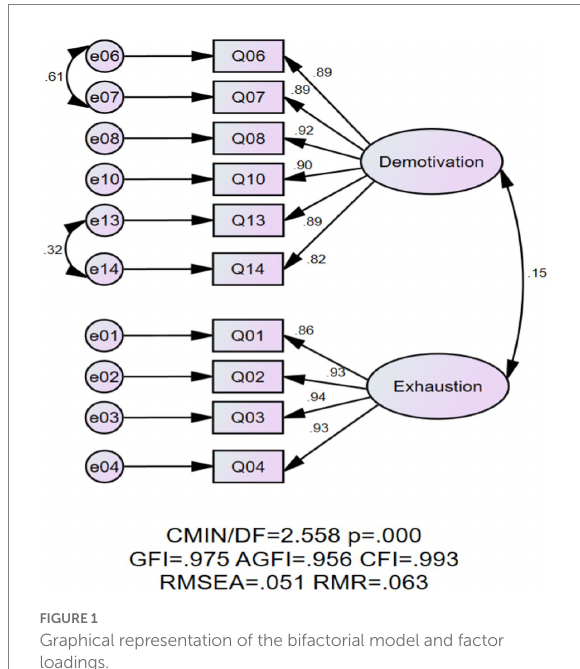
FIGURE 1 Graphical representation of the bifactorial model and factor loadings.